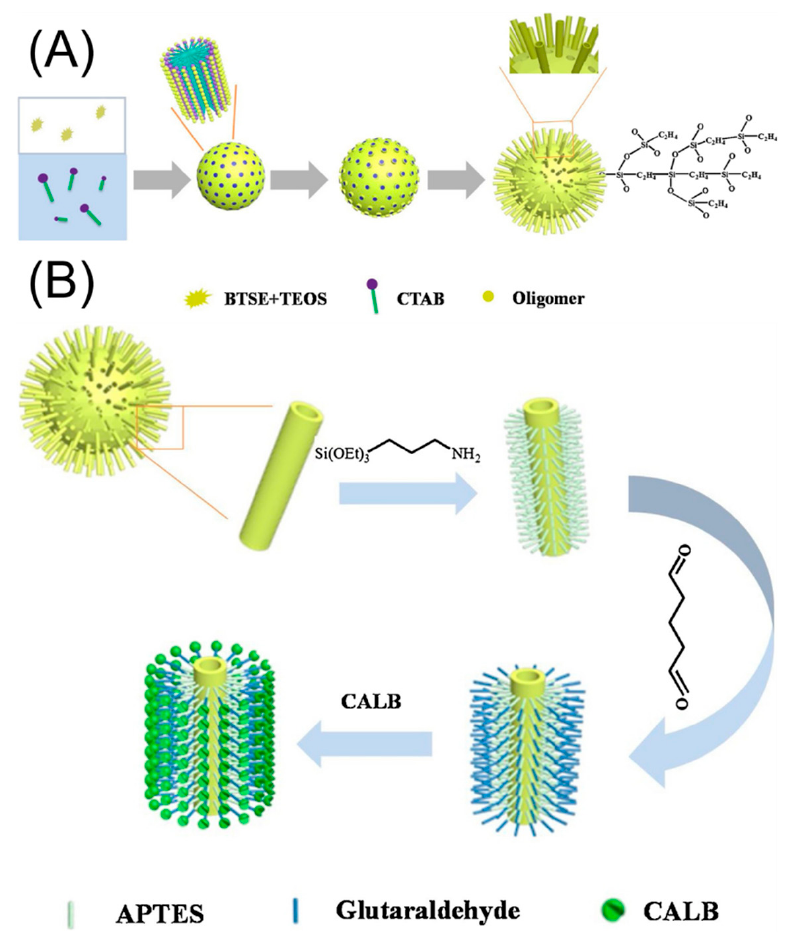
Figure 5. ( A ) Schematic illustration of the formation process of hydrophobic virus-like organosilica nanoparticles VOSNs and ( B ) preparation of the hydrophobic virus-like organosilica nanoparticles immobilized lipase B from Candida antarctica . Reprinted from Jiang et al. [20], with permission from Elsevier. Copyright (2019) Elsevier B.V.